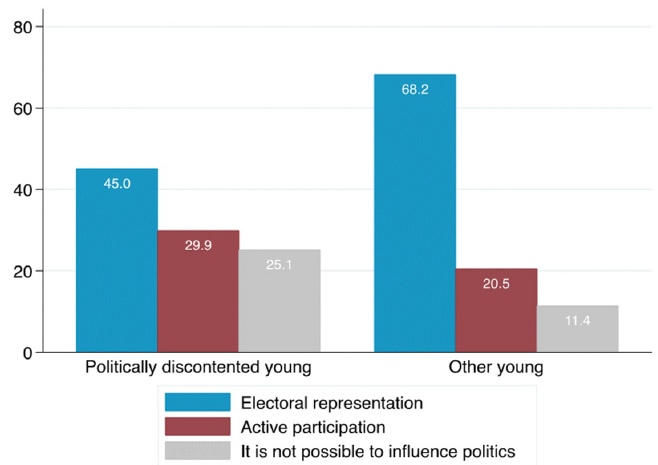
Figure 11. Self-perceived most effective forms of influence in politics. Source: Young People in Spain Survey, 2016.